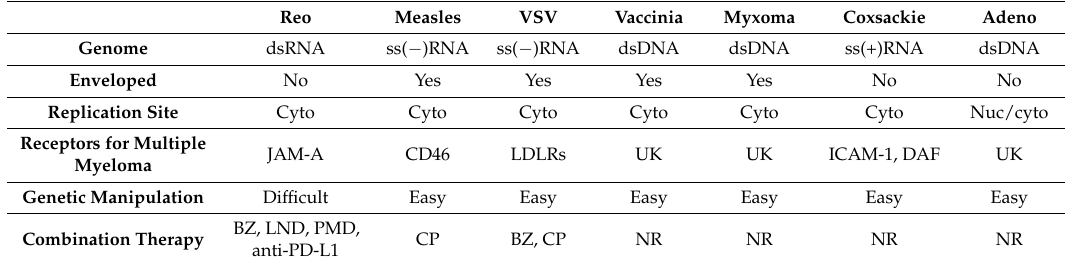
Table 1. Oncolytic viruses currently being developed for multiple myeloma